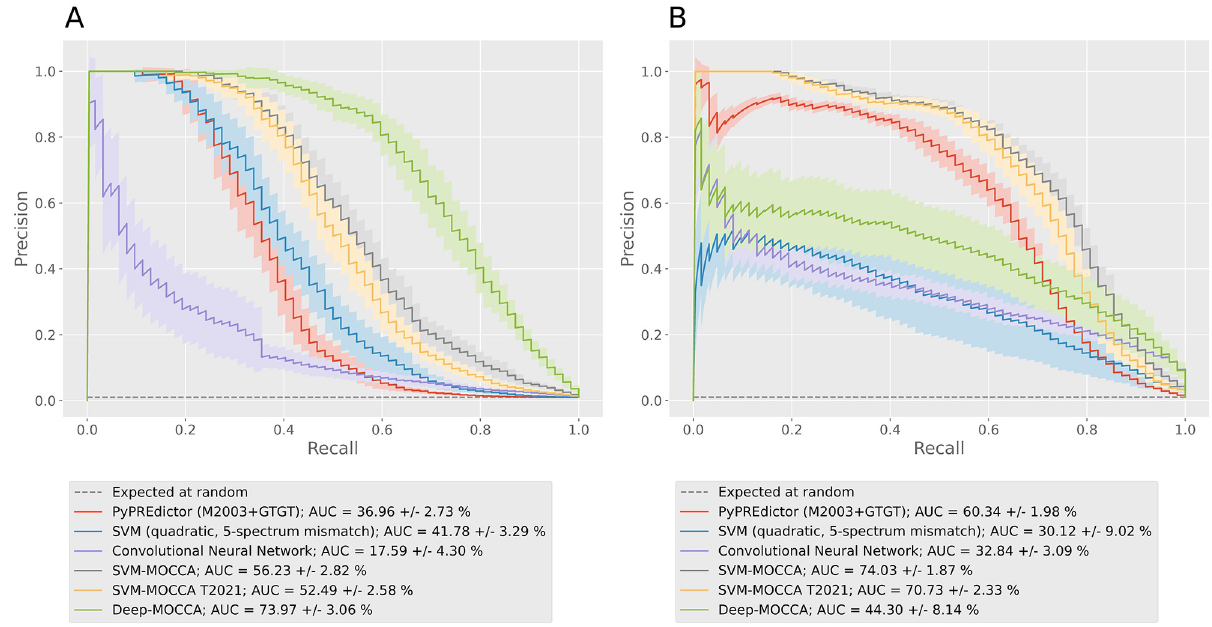
Fig 2. Cross-validation Precision/Recall curves. We cross-validated our models trained with PREs and non-PREs, and tested with independent A) PREs versus dummy PREs and B) PREs versus coding sequences.